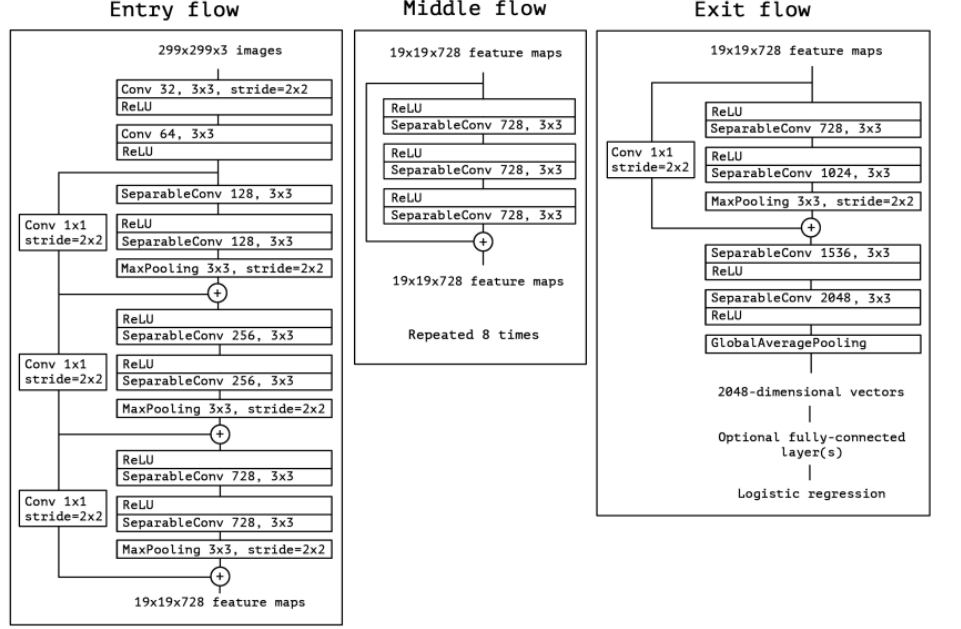
Figure 2. The Xception architecture